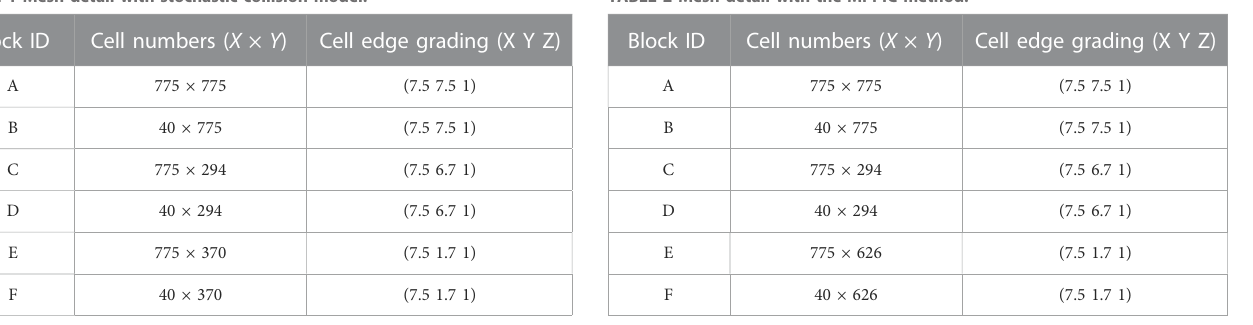
TABLE 1 Mesh detail with stochastic collision model. TABLE 2 Mesh detail with the MPPIC